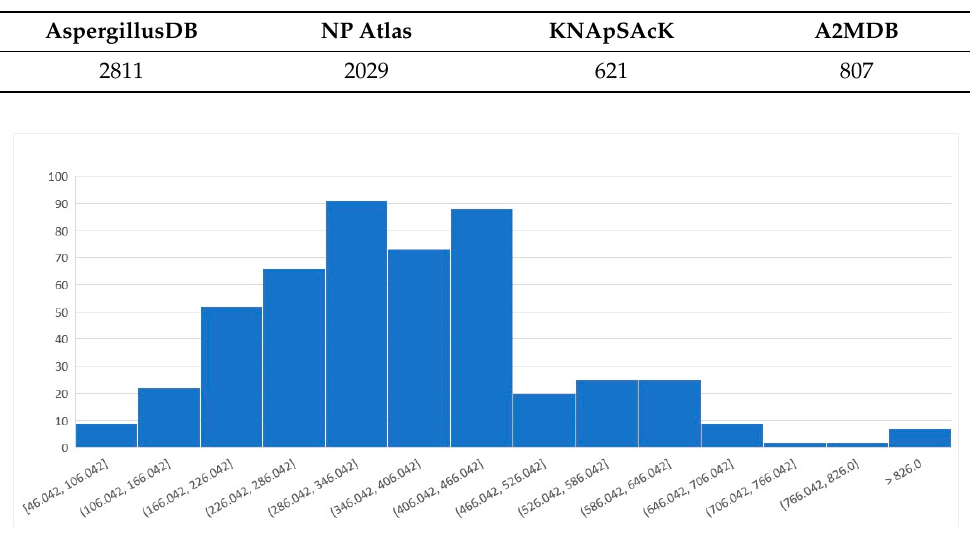
Table 2. Number of Aspergillus compounds in Aspergillus DB, NP Atlas, KNApSAcK, and A2MDB.